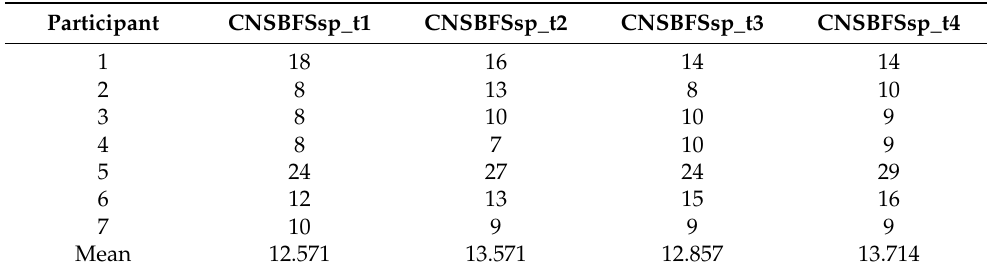
Table 7. CNS-BFS speech subscore (points) individual and mean measurements at four assessment time